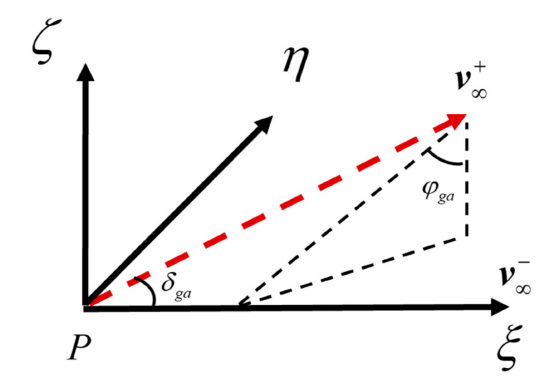
Figure 1. Lunar flyby coordinate